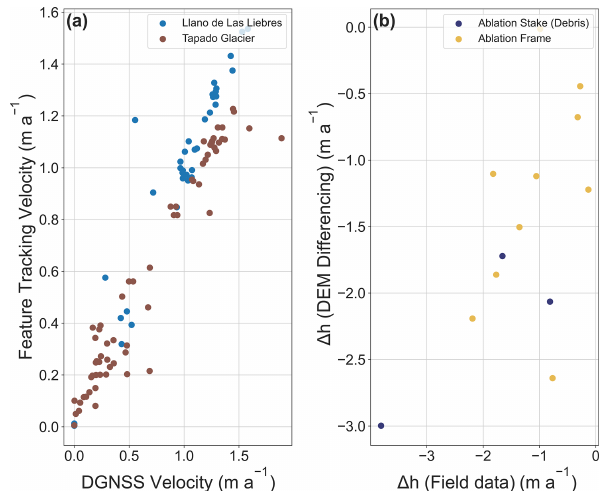
Figure 7. (a) Comparison of surface velocities derived from opti- cal feature tracking with displacements measured with a DGNSS. (b) Comparison between surface elevation changes between 2012 and 2015 derived from remote sensing and surface elevation change measured at ablation stakes between 2011 and 2012 and between 2014 and